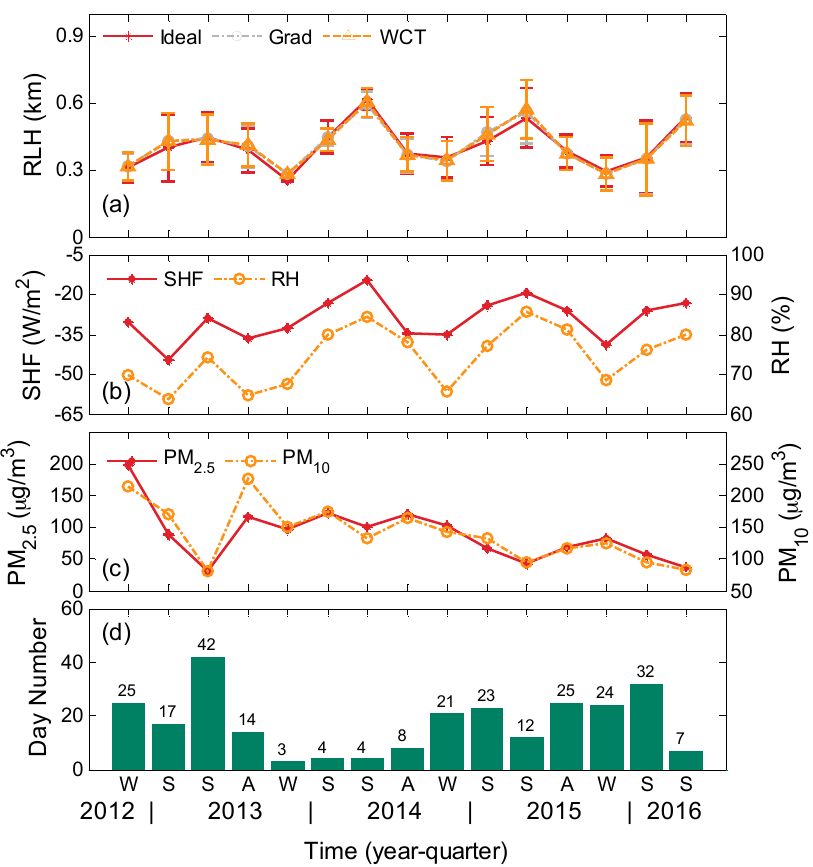
Figure 4. ( a ) Inter-annual quarterly mean LiDAR-derived ABLHs through three different approaches in Wuhan from 5 December 2012–17 June 2016. The error bars represent the corresponding standard deviations; ( b ) corresponding seasonal mean temperature (left y -axis) and wind speed (right y -axis) near the surface; ( c ) corresponding seasonal mean of PM 2.5 (left y -axis) and PM 10 (right y -axis) near the surface; and ( d ) quarterly distribution of day number in the statistical analysis.